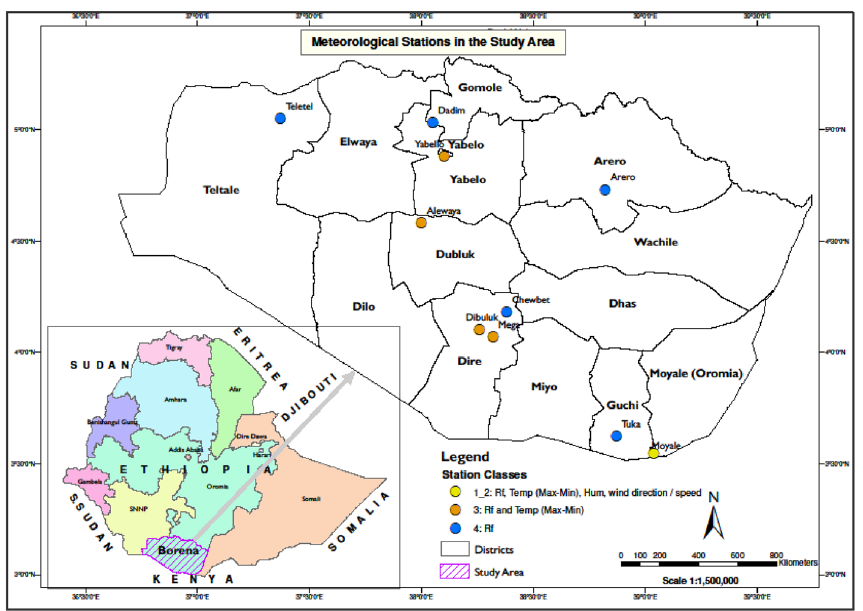
Figure 1. Study area and locations of meteorological stations. (Source: Humanitarian Data Exchange-Ethiopia Shape file and NMA station GPS